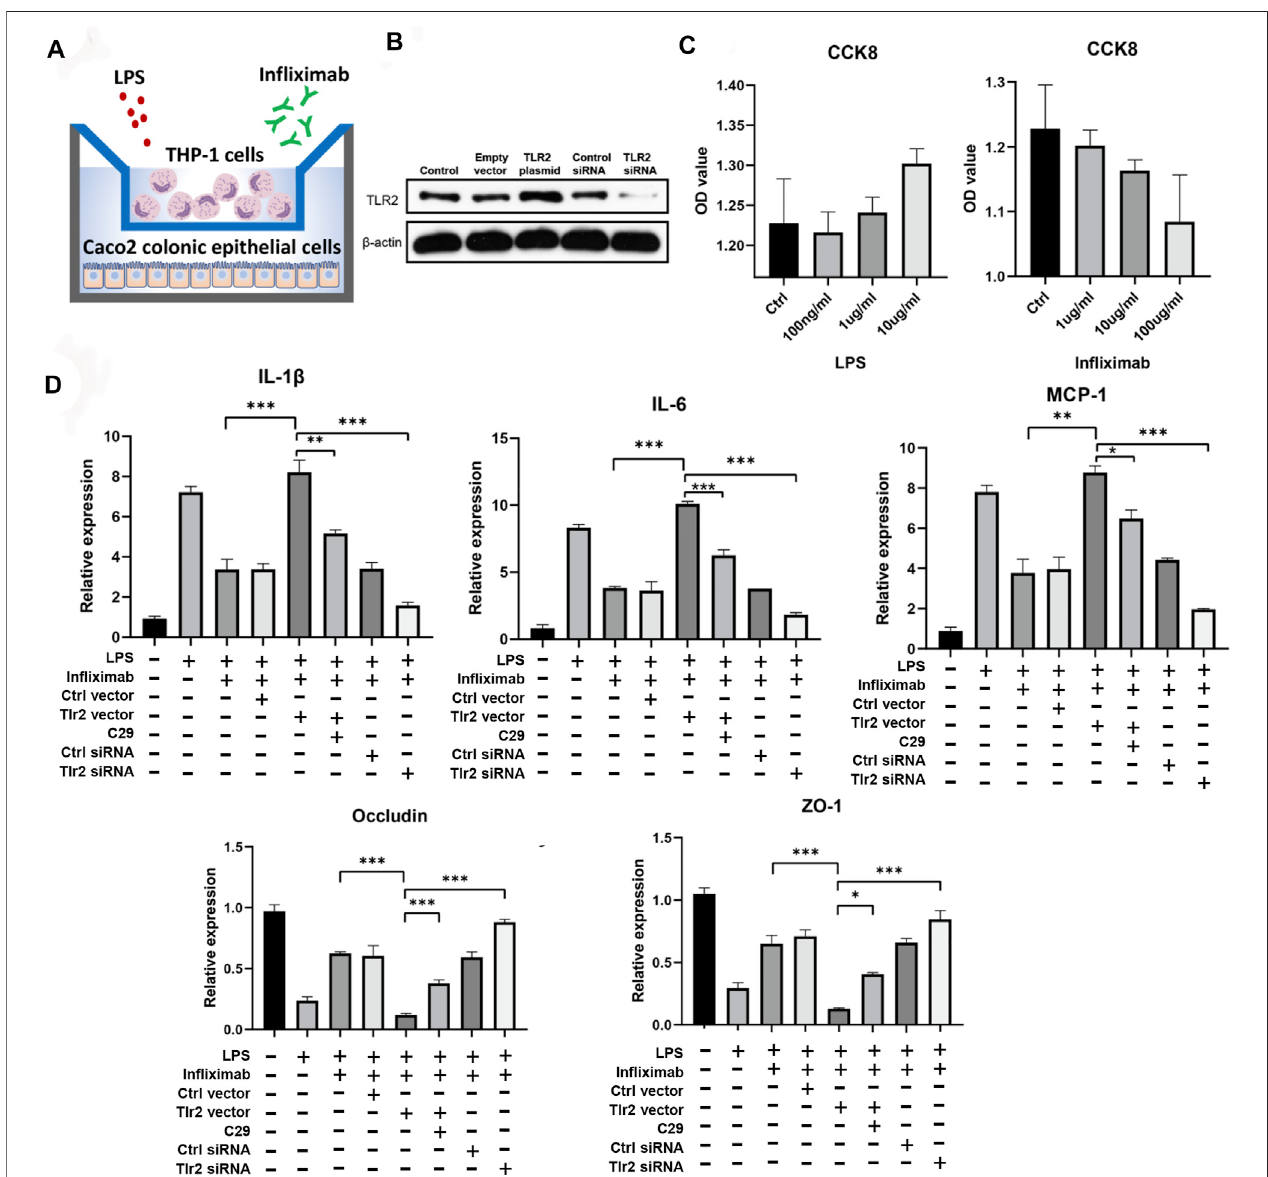
FIGURE 6 | Experimental validation of core predictors. (A) Coculture system of THP1 and Caco2 cells. (B) Validated Western blotting results for TLR2 overexpression and knockdown. (C) CCK8 results for in fl iximab and LPS in Caco2 cells. (D) RT-qPCR results for cocultured Caco2 cells after in fl iximab treatment in the context of LPS-induced in fl ammation (one-way ANOVA, * p < 0.05, ** p < 0.01, and *** p < 0.001).